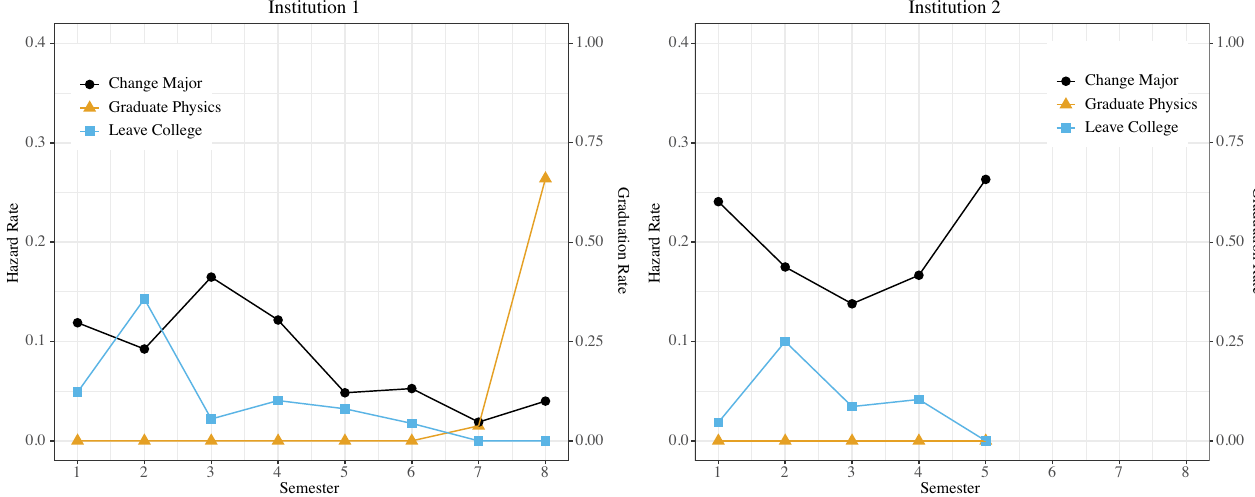
FIG. 3. Hazard functions. The graduation hazard is plotted on a different scale shown by the right vertical axis. For Institution 1, each semester plotted has at least 50 students enrolled as physics majors. Only 5 semesters could be plotted for the smaller Institution 2; these semesters enroll 54, 40, 29, 24, and 19 students,